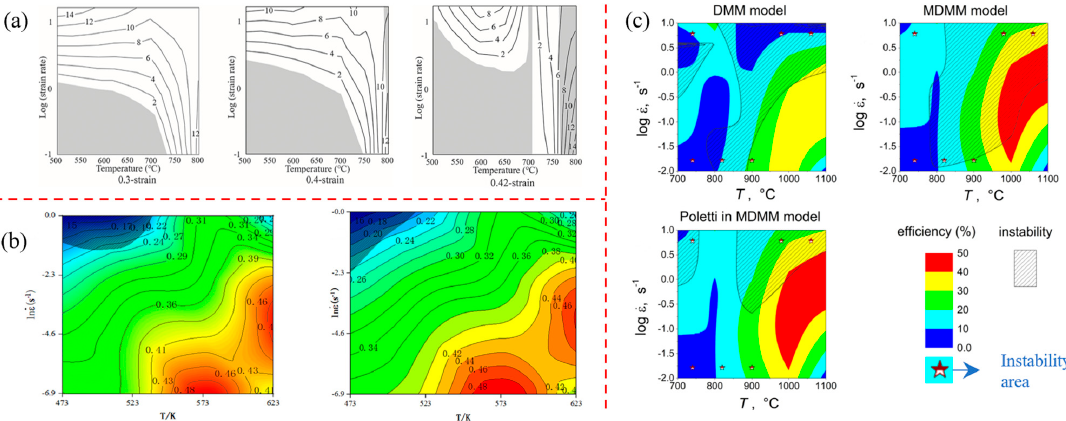
Figure 7. Hot processing diagrams of different materials during compression: ( a ) the gray area is the deformation instability area of the Ti-6Al-4V titanium alloy [94]; ( b ) the dark blue area is the deformation instability area of the dual-phase Mg-9Li-3Al alloy [96]; ( c ) ★ indicates the deformation instability point of stabilized micro-alloyed steel [98].